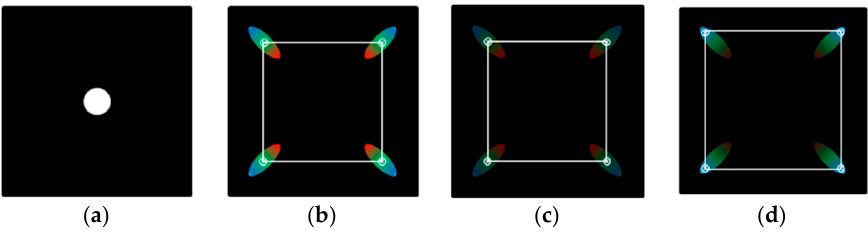
Figure 5. Principle of measurement: ( a ) shows the ideal spot image of a star, as seen through the payload without the pyramid; ( b ) shows the ideal spot image of a star as seen through the payload with the pyramid; the four spots are dispersed and the centroids (white circles) are joined by white lines to show their relative distances; ( c ) shows the case of image ( b ) during the transit of a planet, a uniform decrement of luminosity determines no shift of centroids; ( d ) shows the case of image ( b ) during a false positive transit, where the non-uniform decrement of luminosity determines the shift of centroids and then the change of their relative